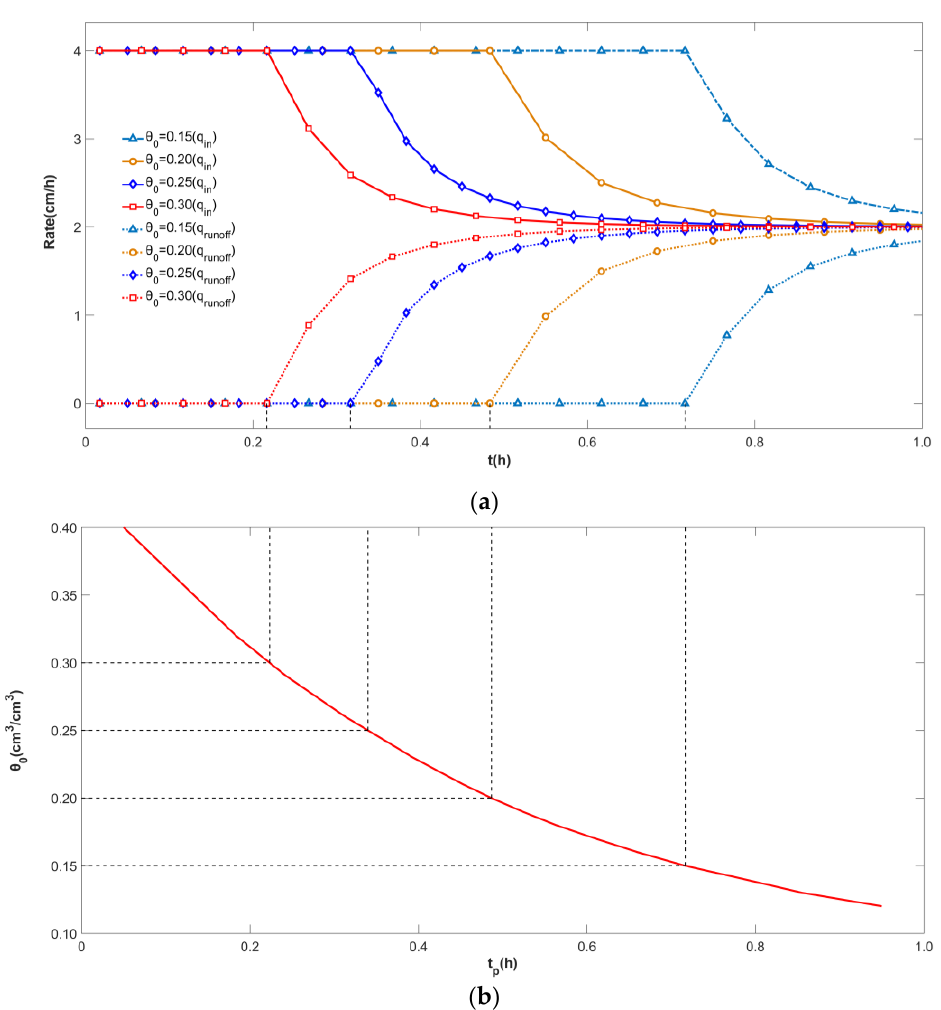
Figure 6. Infiltration and runoff versus time with different initial soil water contents. ( a ) Infiltration and runoff rate with different initial soil water contents; ( b ) Runoff time versus initial soil water contents.